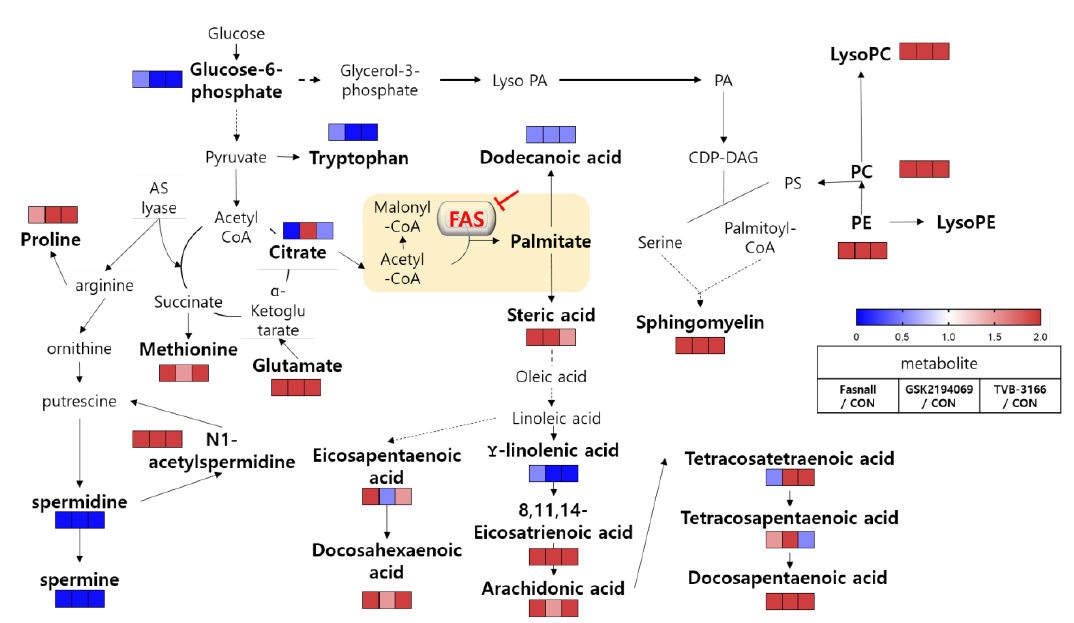
Figure 12. Overview of metabolic pathway analysis. Blue color boxes indicate a decrease in compounds and metabolic pathways, while red boxes indicate an increase. Bold indicates significantly changed metabolites.